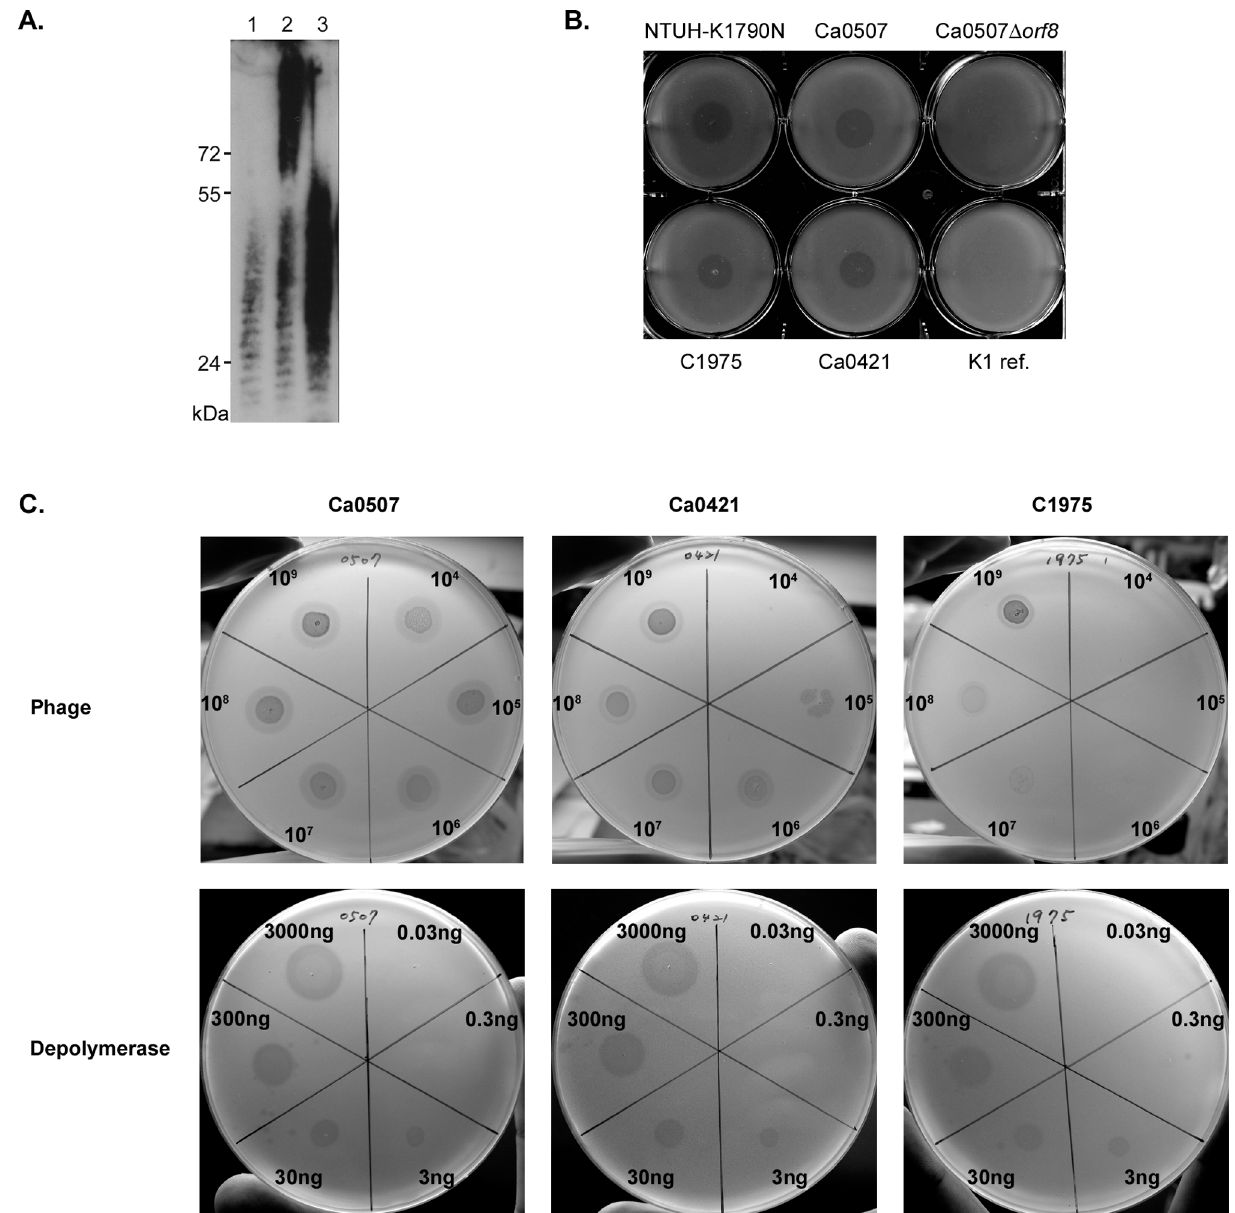
Figure 5. Bacteriophage-derived depolymerase specific for KN2 capsular polysaccharides. ( A ) Immunoblot showing depolymerzation of KN2 extracted capsular polysaccharides by purified ORF96 proteins. The extracted capsular polysaccharides alone or incubated with ORF96 proteins (10 m g) at 37 u C for 6 h were separated by SDS-PAGE, transferred onto a nitrocellulose membrane and detected using rabbit anti-C1975 antiserum (1:5000) and goat anti-rabbit IgG-HRP (1:10 000). Lane1: Ca0507 D orf8 alone; lane2: wild-type Ca0507 alone; lane3: wild-type Ca0507 plus ORF96 proteins. ( B ) A spot test showing ORF96 proteins with the depolymerase activity to KN2. Purified ORF96 proteins (1 m g) was spotted on the bacterial lawn and incubated at 37 u C overnight. Decapsulation of KN2 K. pneumoniae NTUH-K1790N, Ca0507, Ca0421 and C1975 was observed. K1 ref. presents the reference strain of the K1 serotype. ( C ) Comparison of sensitivity of phage 0507-KN2-1 and capsular polysaccharide depolymerase. Spot tests with serial titration (counter-clockwise) of phage 0507-KN2-1 (upper panels) or purified ORF96 proteins (lower panels) on KN2 strains as indicated. of enzyme used can be easily quantified. Therefore, enzyme-based typing is more suitable for large-scale epidemiological studies of capsular type prevalence. Using this more efficient typing method, the prevalence of KN2 capsular type in different K. pneumoniae - mediated diseases can be further investigated.